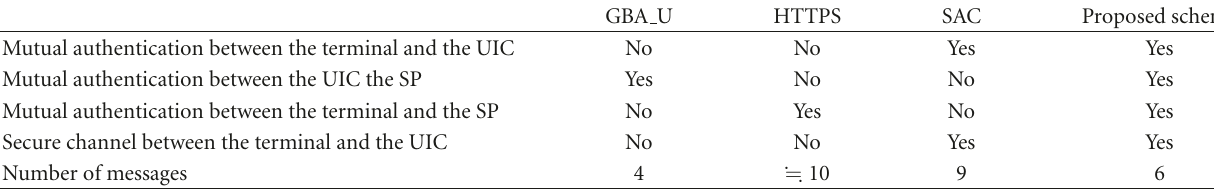
Table 1: Comparison with previous